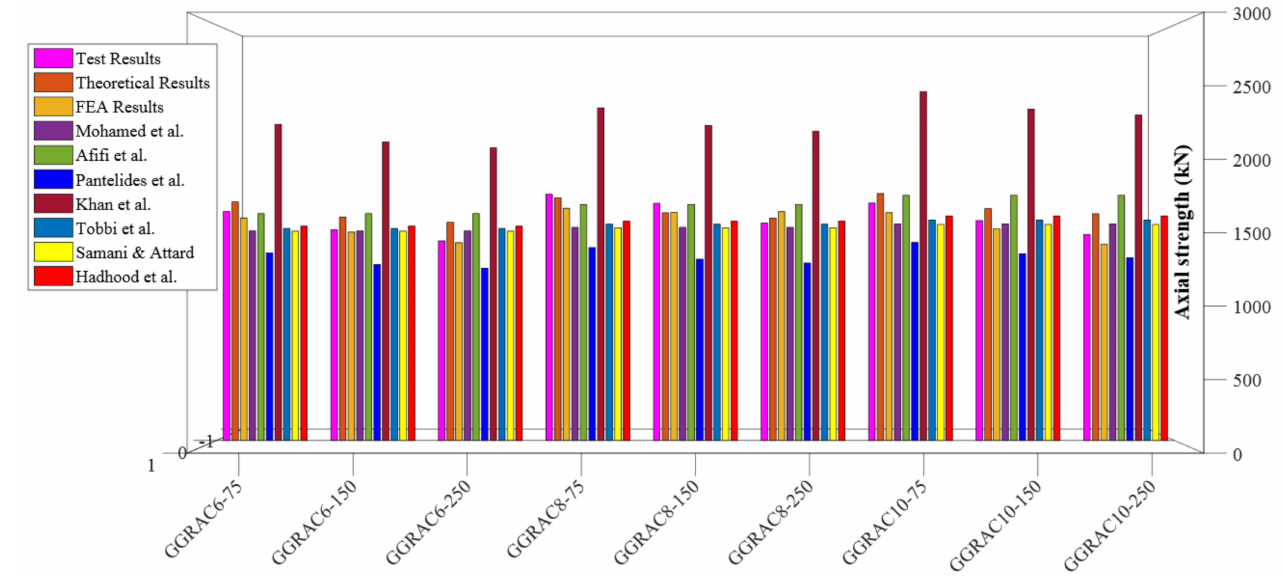
Figure 13. Comparison of estimates of different models for the LCC of GGRAC compressive